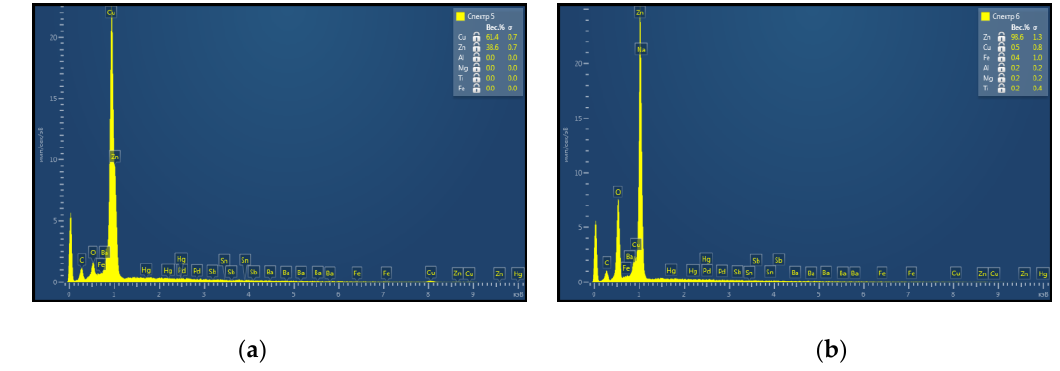
Figure 6. The results of the analysis of the elemental chemical composition: of the initial structure of brass ( a ) and of the surface of the treated material ( b ) after a pulse-periodic laser irradiation.